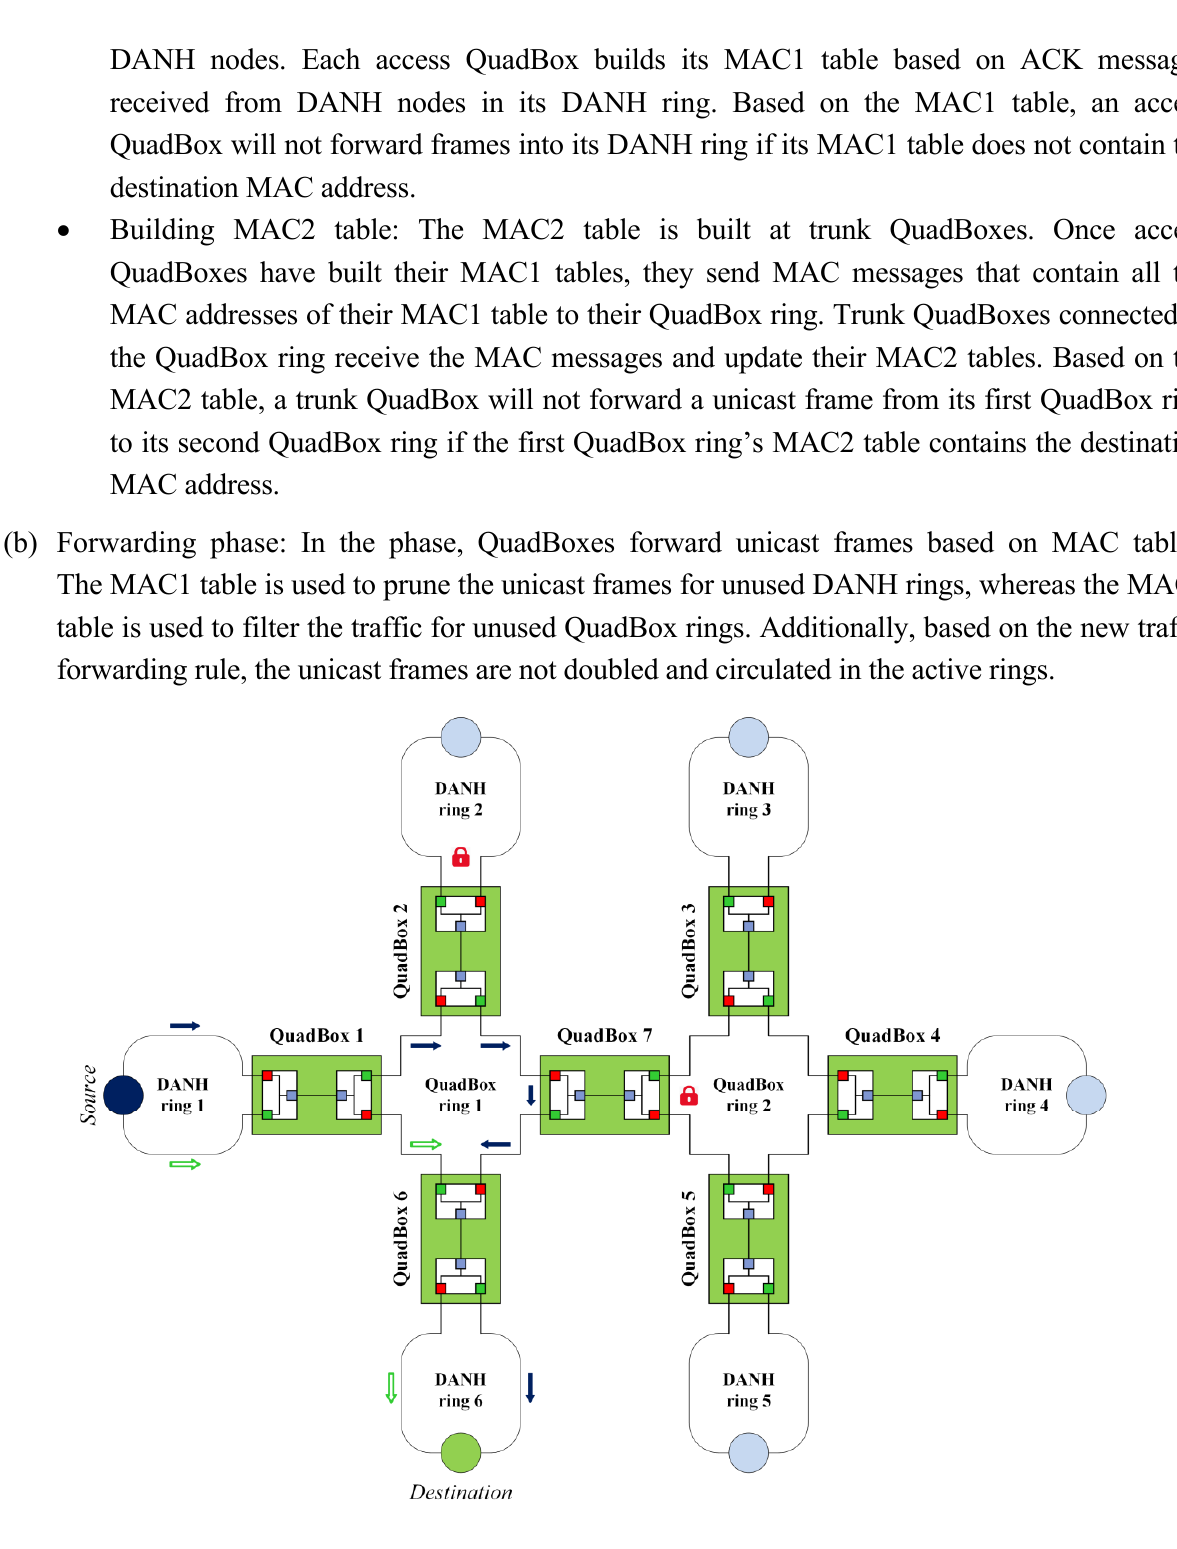
Figure 11. Filtering unicast traffic under the